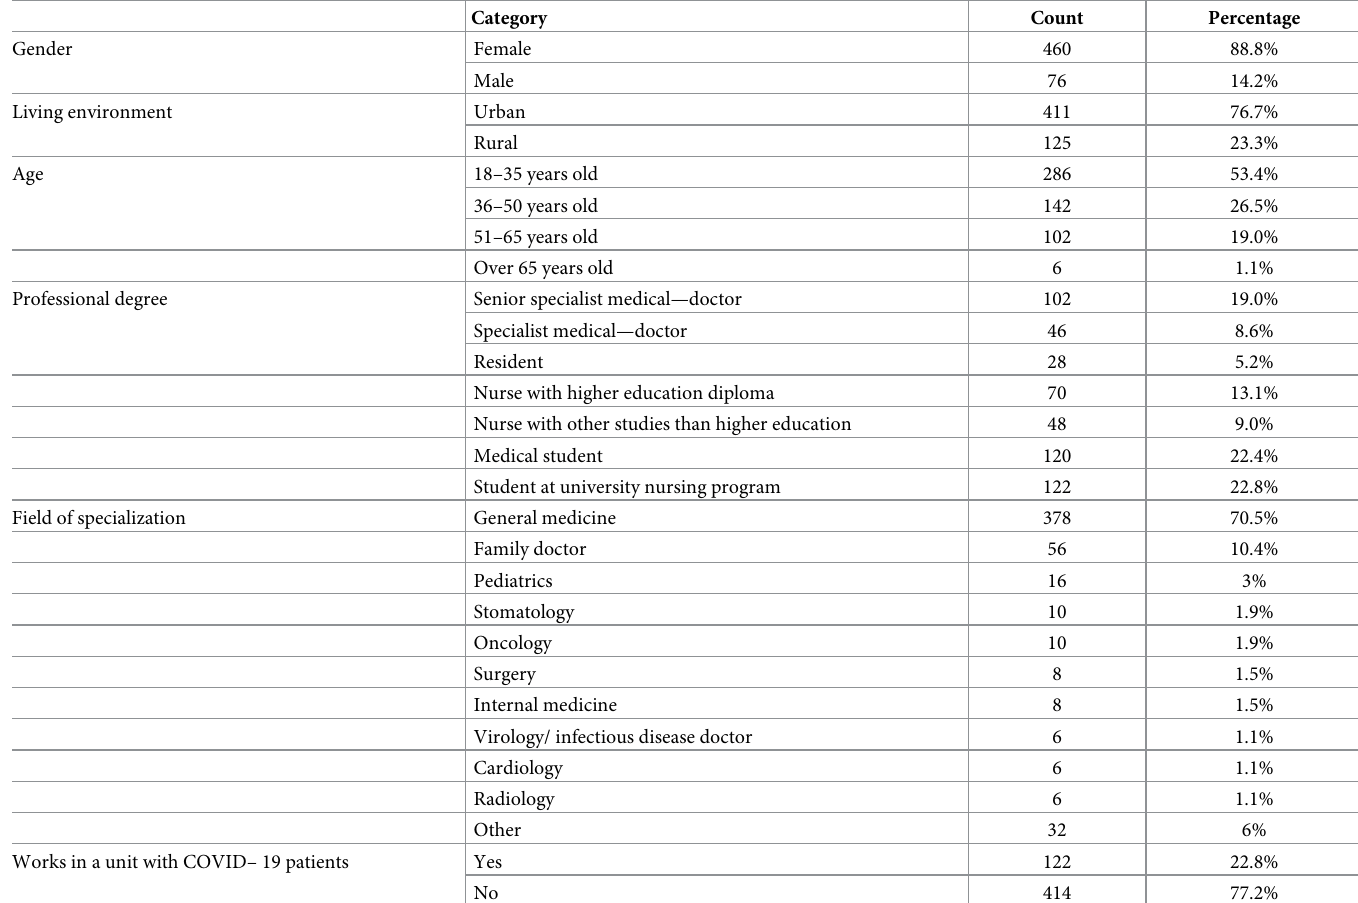
Table 1. Sample characteristics (n =